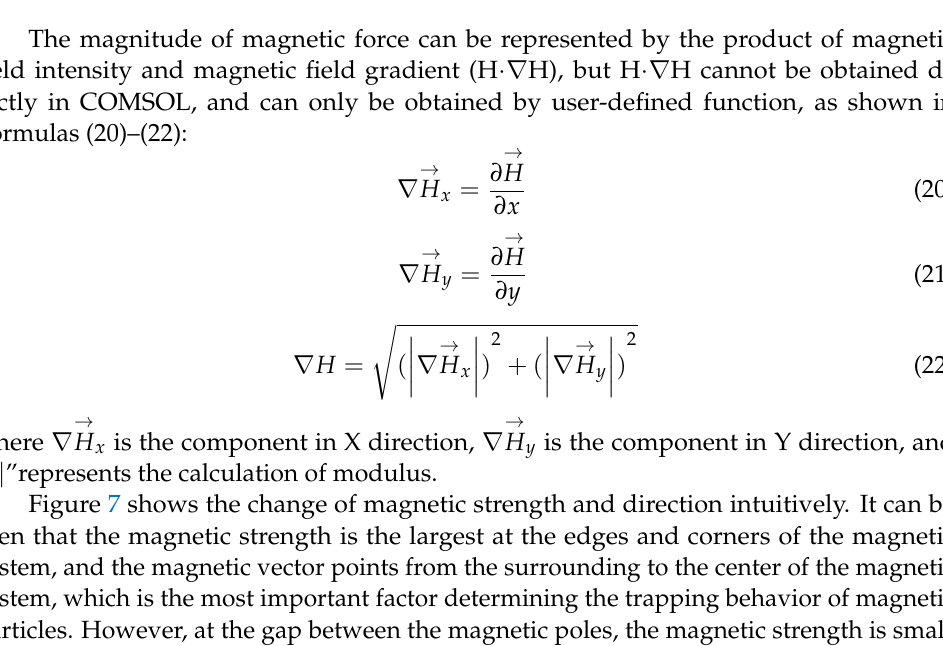
and a small number of vector arrows point in the opposite direction, which may cause some magnetic particles to some magnetic particles to deviate.